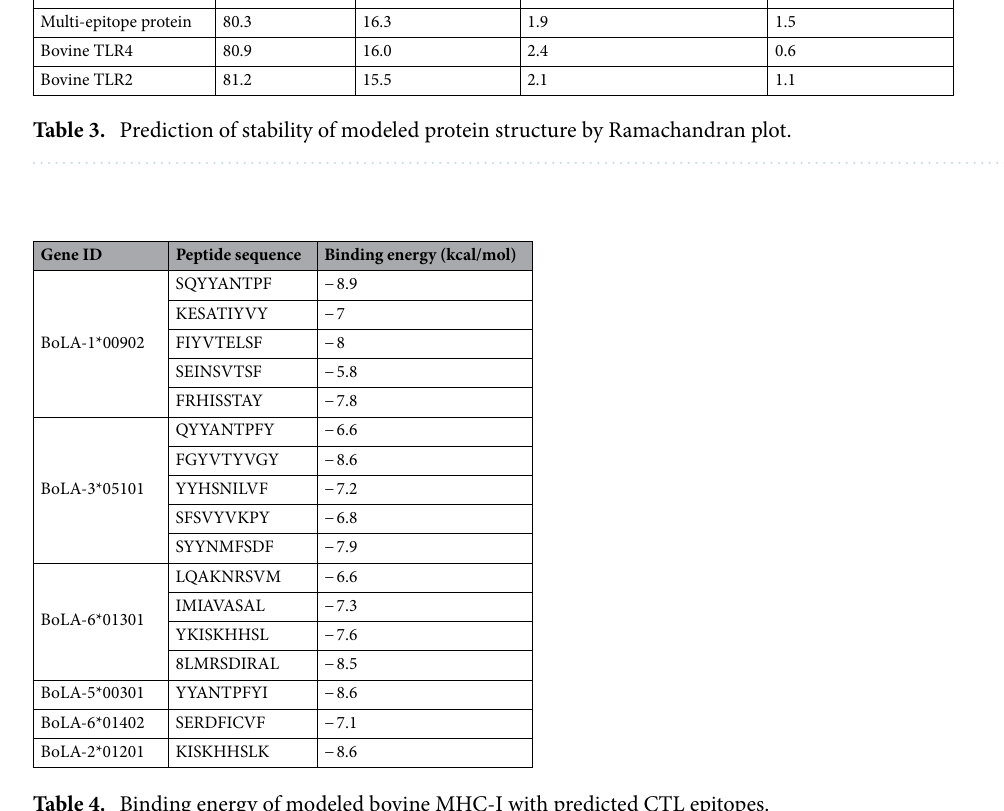
Table 4. Binding energy of modeled bovine MHC-I with predicted CTL